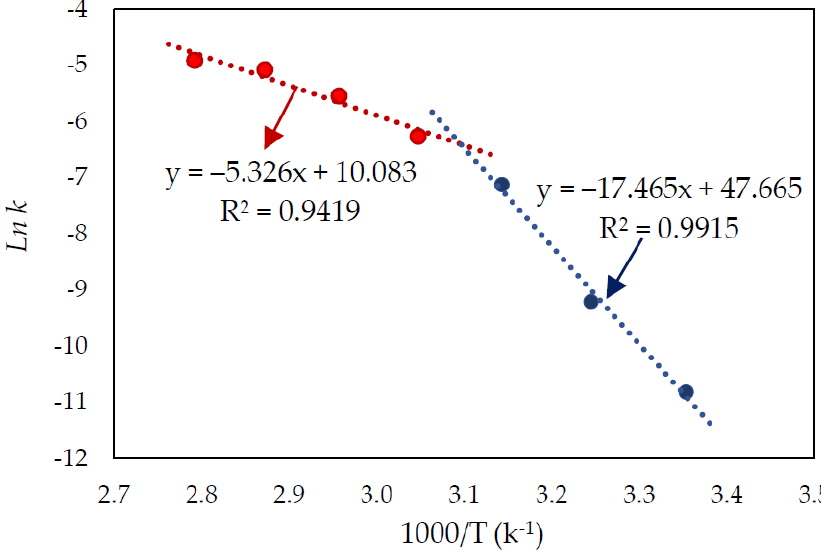
Figure 10. Arrhenius plot of lnk vs. 1000/T (k − 1 ). The function of the equation 1/3ln (1 − X) + [(1 − X) − 1/3 − 1] = k.t versus time was also